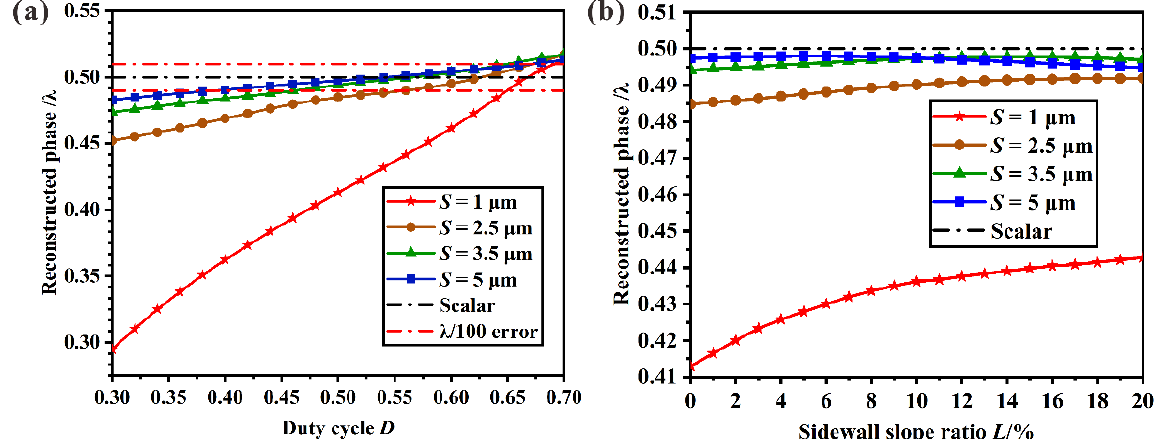
Figure 5. Reconstructed phase based on scalar approximation and rigorous simulation for the grating model with ( a ) a variable duty cycle or ( b ) a variable sidewall slope ratio, for different periods subject to TE polarization.